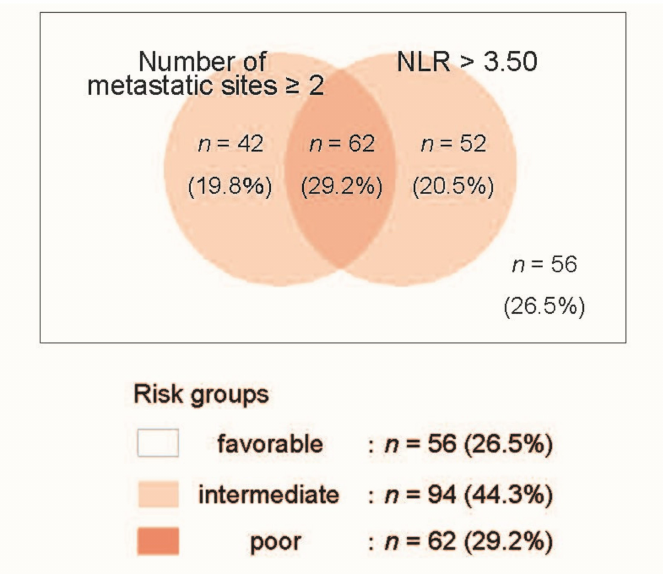
Figure 3. Venn diagram of the risk model using two risk factors, including the number of metastatic sites (1/ ≥ 2) and the neutrophil–lymphocyte ratio ( ≤ 3.50/>3.50) at the initiation of pembrolizumab treatment in 212 mUC patients.